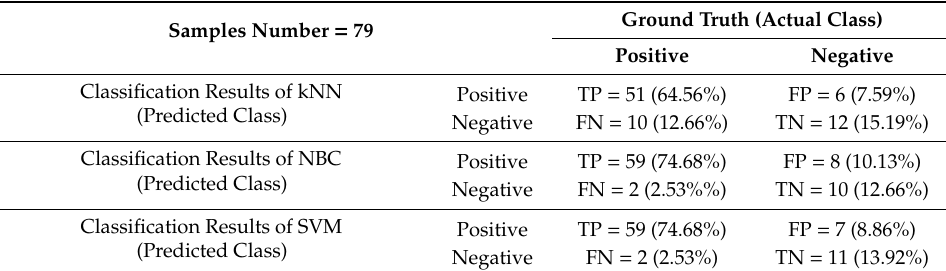
Table 3. The confusion matrix of assessing BFV.